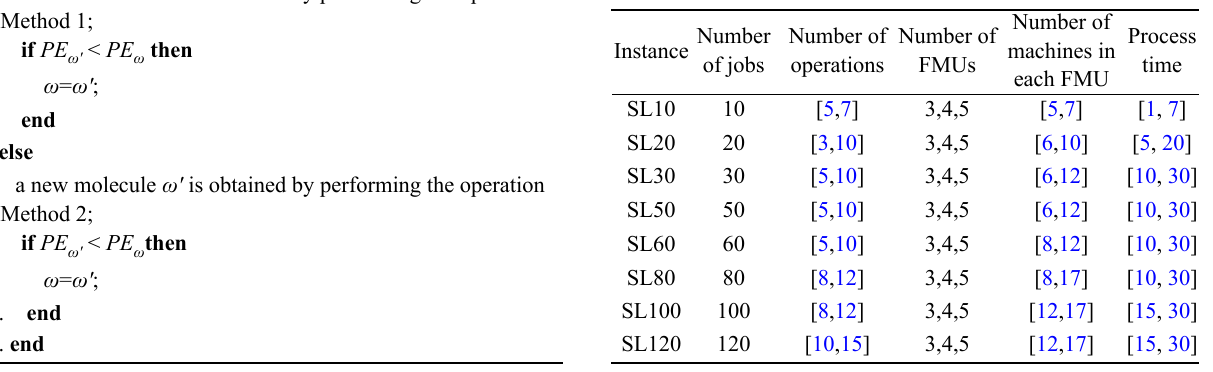
Table 4 Parameters used to generate the